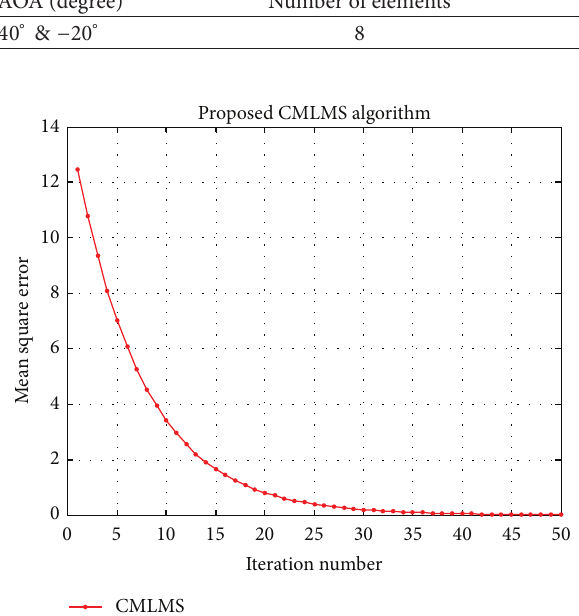
Figure 4: Convergence behavior of CMLMS algorithm.